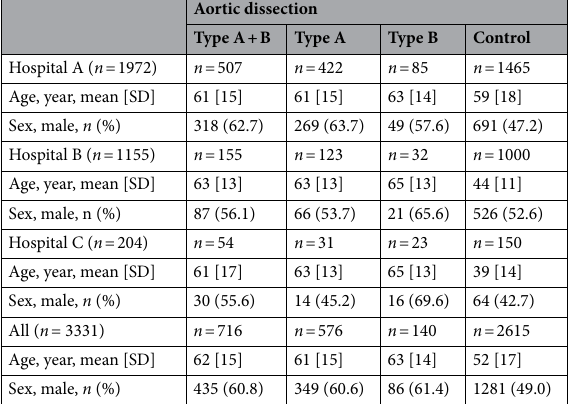
Table 1. Baseline characteristics of participants who provided images for the data sets. Continuous variables are presented by mean [standard deviation] and categorical variables are presented by N (%); SD standard